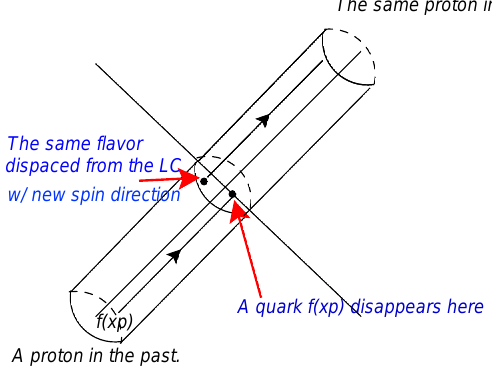
Figure 3: Illustration of the matrix element for a collinear or transverse momentuum distribution. A quark is removed from the proton, and reinserted at a point on or near the opposite-moving light